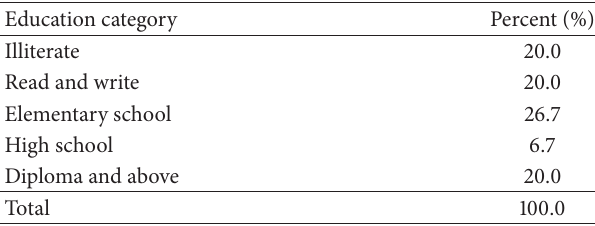
Table 2: Educational status of respondents ( 𝑁 = 90 ).